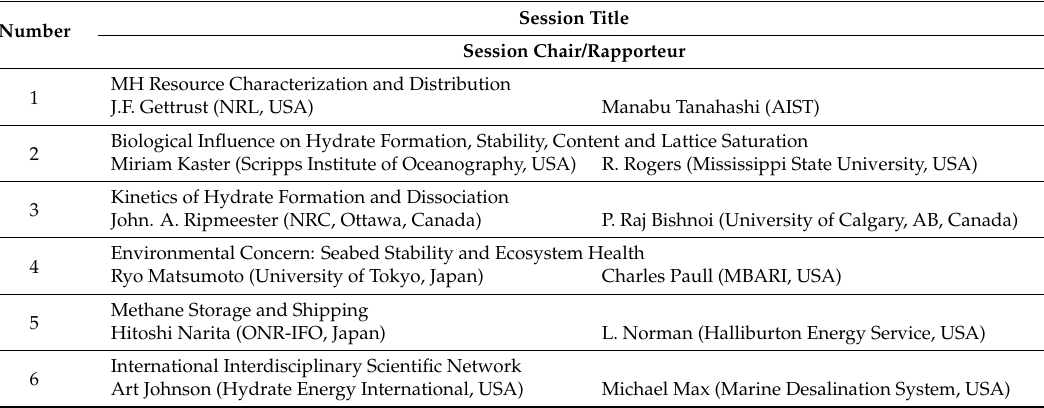
Table 3. Breakout sessions (title and